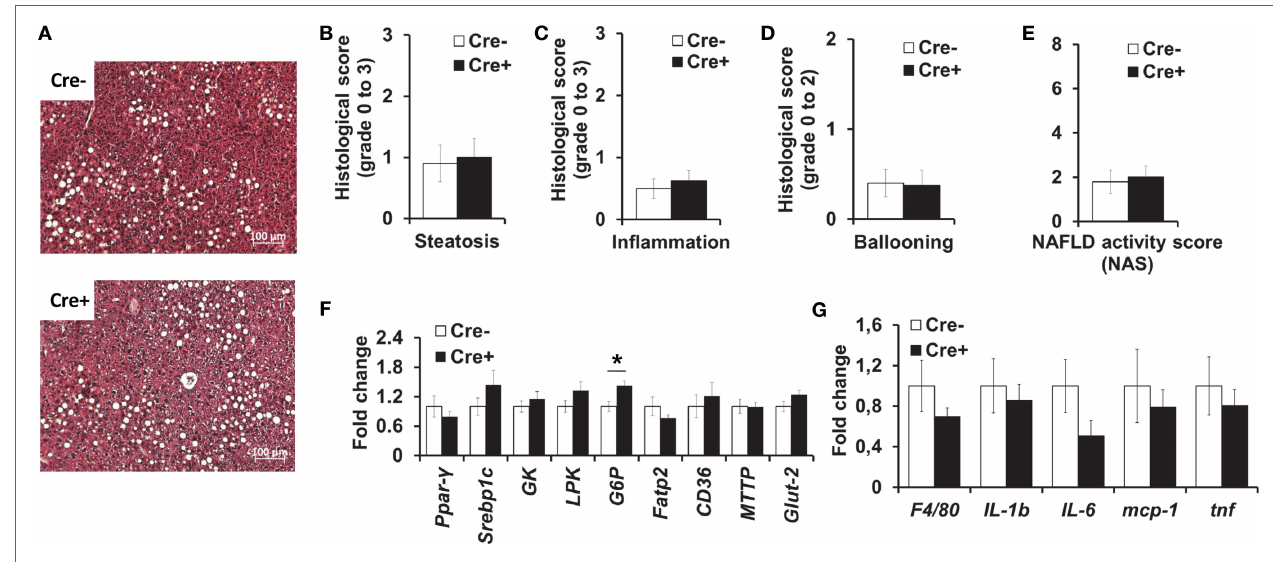
FigUre 4 | no difference in liver inflammation and metabolism between obese mast cell-deficient and -proficient mice . (a–e) Liver hematoxylin/ eosin-stained paraffin sections from obese mast cell-deficient and -proficient mice were analyzed histologically and evaluated for NAFLD activity score (NAS), consisting of steatosis, lobular inflammation, and hepatocellular ballooning; three sample images (400 × power field) per animal were scored ( n = 8–10 mice). Student’s t -test was used for statistical analysis; data are expressed as means ± SEM. (a) Representative images of the liver from obese mast cell-deficient and -proficient mice. (B) Liver steatosis was scored on a scale from 0 to 3. (c) Liver lobular inflammation was scored on a scale from 0 to 3. (D) Hepatocellular ballooning was scored on a scale from 0 to 2. (e) NAFLD activity score (NAS) represents the combination of steatosis, inflammation, and ballooning score on a scale from 0 to 8. (F,g) Quantitative PCR analysis from the livers of obese mast cell-deficient and -proficient mice was performed. Data are shown relative to the mast cell-proficient mouse group; 18S RNA was used for normalization. Non-parametric Mann–Whitney U test was used for statistical analysis; data are expressed as means ± SEM ( n = 8–10 mice). (F) Quantitative PCR analysis of metabolic gene expression in the liver; * p < 0.05. (g) Quantitative PCR analysis of inflammatory gene expression in the